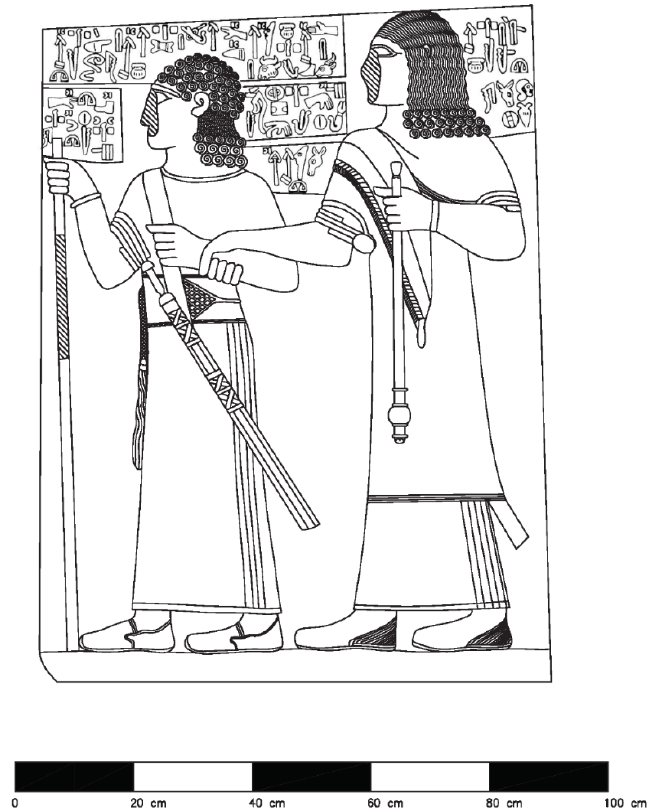
Figure 5. Royal Buttress, Slab B7a: Kamani, the young heir apparent to the throne, firmly led forward by Yariri, the acting regent (drawing by Elia Bettini).